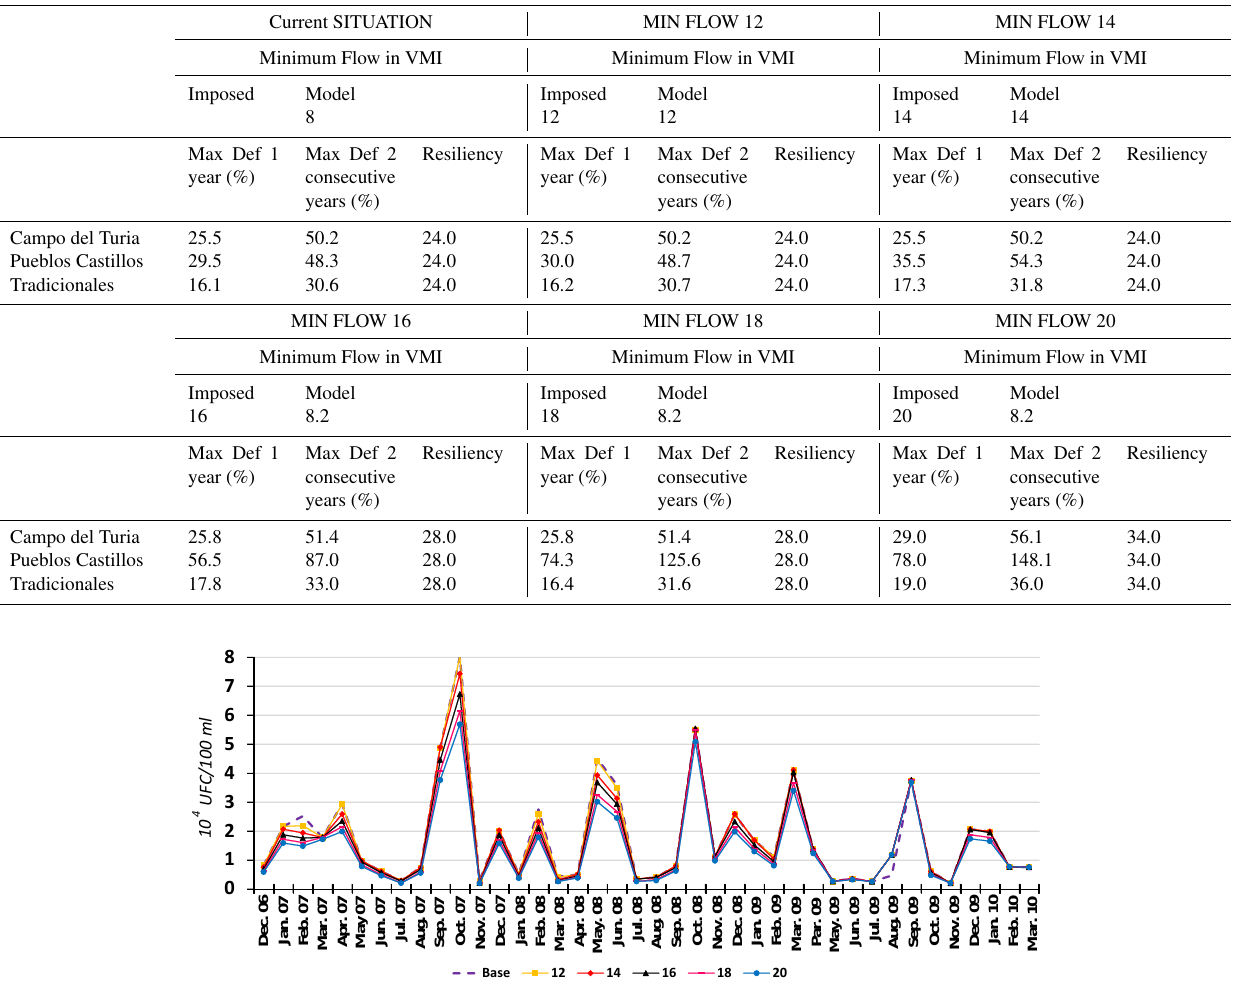
Table 1. Summarised results for the reliability (Max Def 1 year (%): maximum annual water supply deficit as % of the annual water demand; Max Def 2 consecutive years (%): maximum accumulated water supply deficit in two consecutive years as % of the annual water demand) and resiliency (maximum number of consecutive months with deficit) of the three agricultural water demands for the current situation and for different imposed minimum flows at river stretch where the Valencia City water intake (VWI) is located (MINFLOW: 12, 14, 16, 18 and 20m 3 s − 1 ).